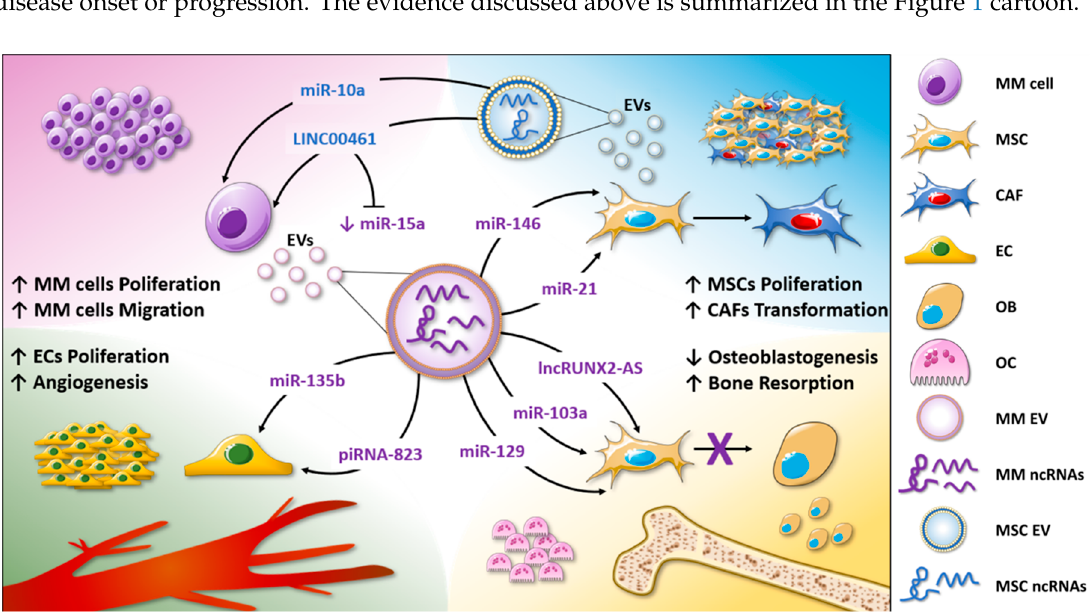
Figure 1. EV-associated ncRNAs are involved in MM biological functions. The non-coding RNA content of MM-EVs is involved in the enhanced tumor cell proliferation and migration (purple corner), in MSC proliferation, and CAF transformation (light-blue corner); additionally, by delivering ncRNAs, MM-EVs induce angiogenesis, promoting endothelial cell proliferation and the release of angiogenic factors (green corner). Finally, EVs regulate MM bone disease by altering osteoclast and osteoblast functions (yellow corner).